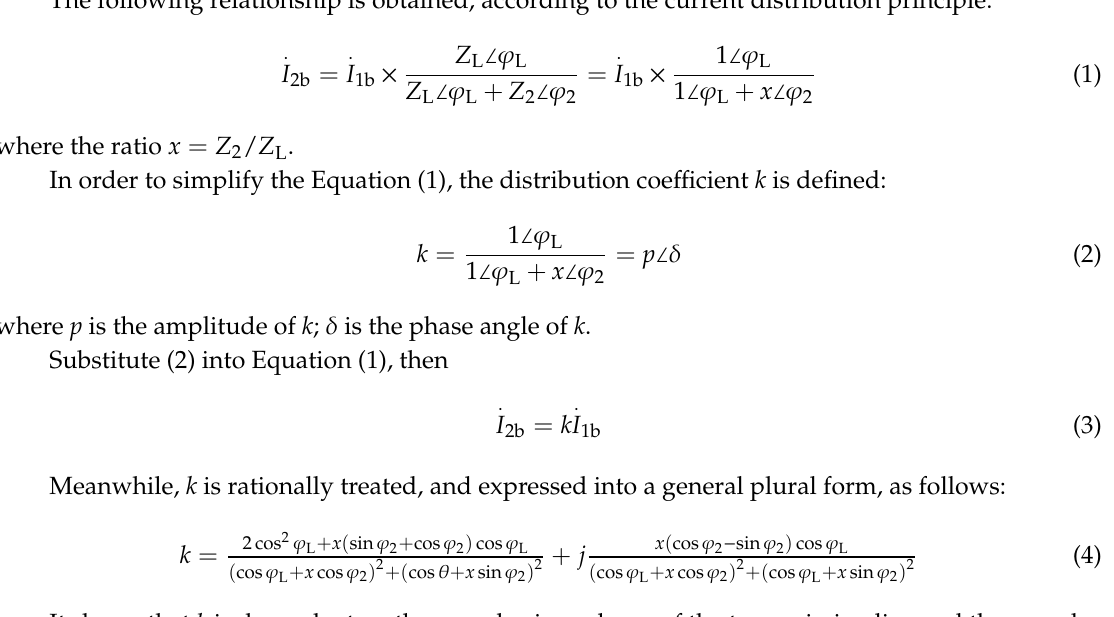
Figure 4. Equivalent circuit when DVR acts alone; sensitive load and the adjacent load, respectively, provided by DVR after the voltage sag, compensation current distributed by the DVR to the other branches in the system, here means the branch to which the original source belong.